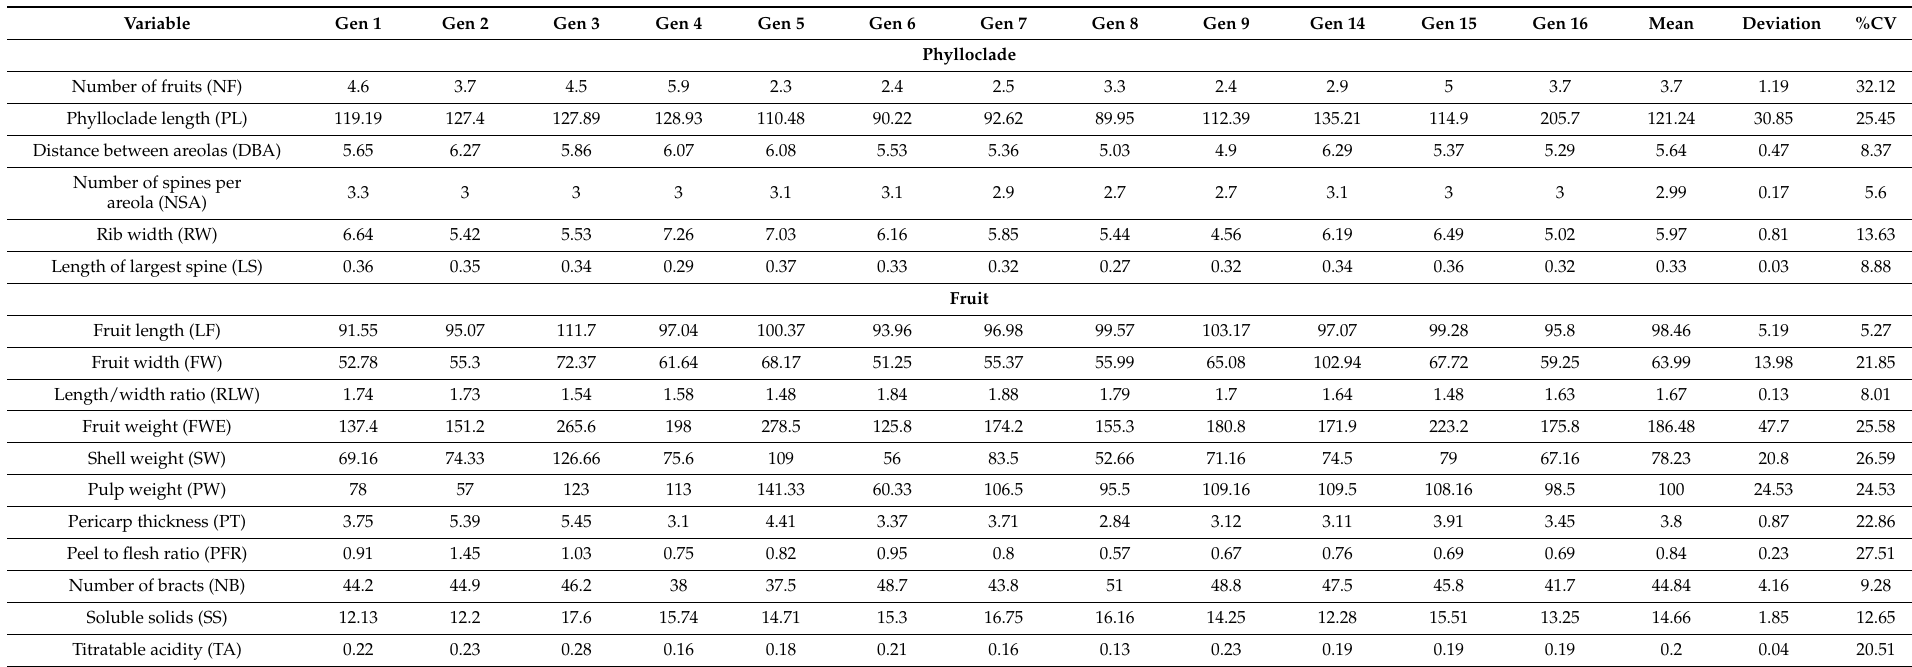
Table 6. Descriptive statistics of quantitative morphoagronomic descriptors of fruit and phylloclade in the undercover